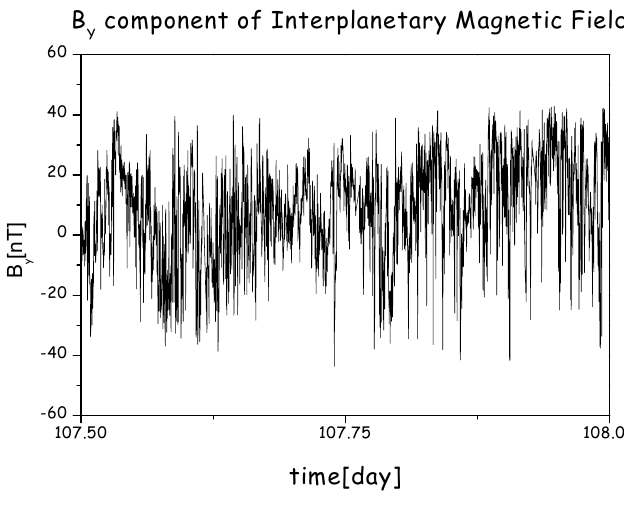
Figure 114: 𝐵 𝑌 component of the IMF recorded within a high velocity